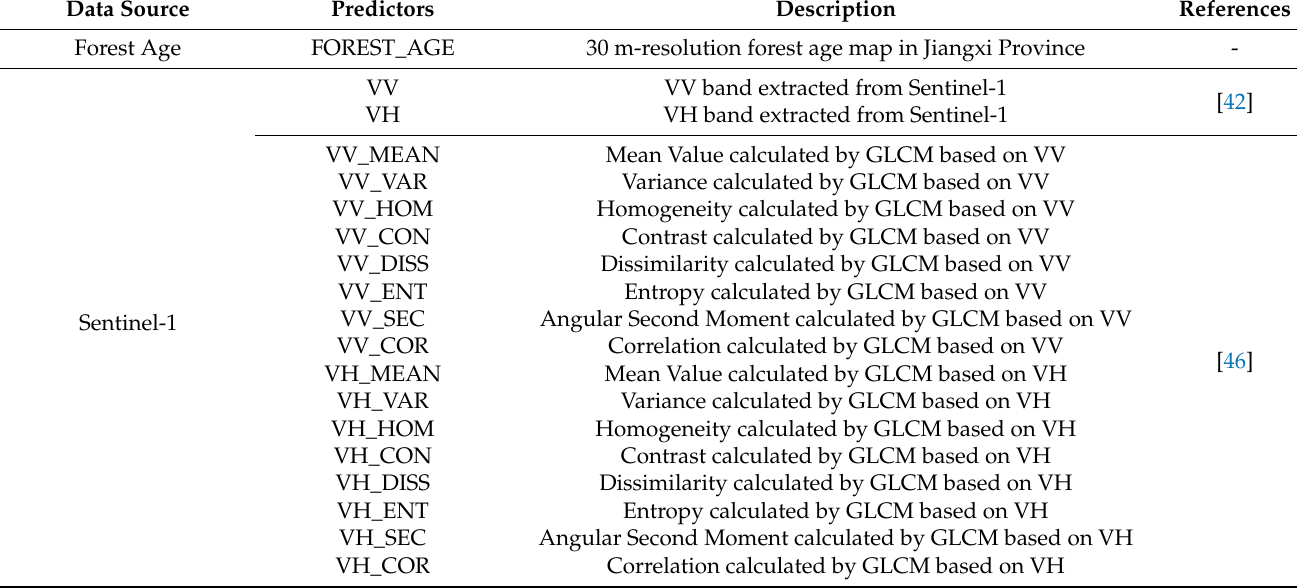
Table 1. Predictors obtained by multi-source